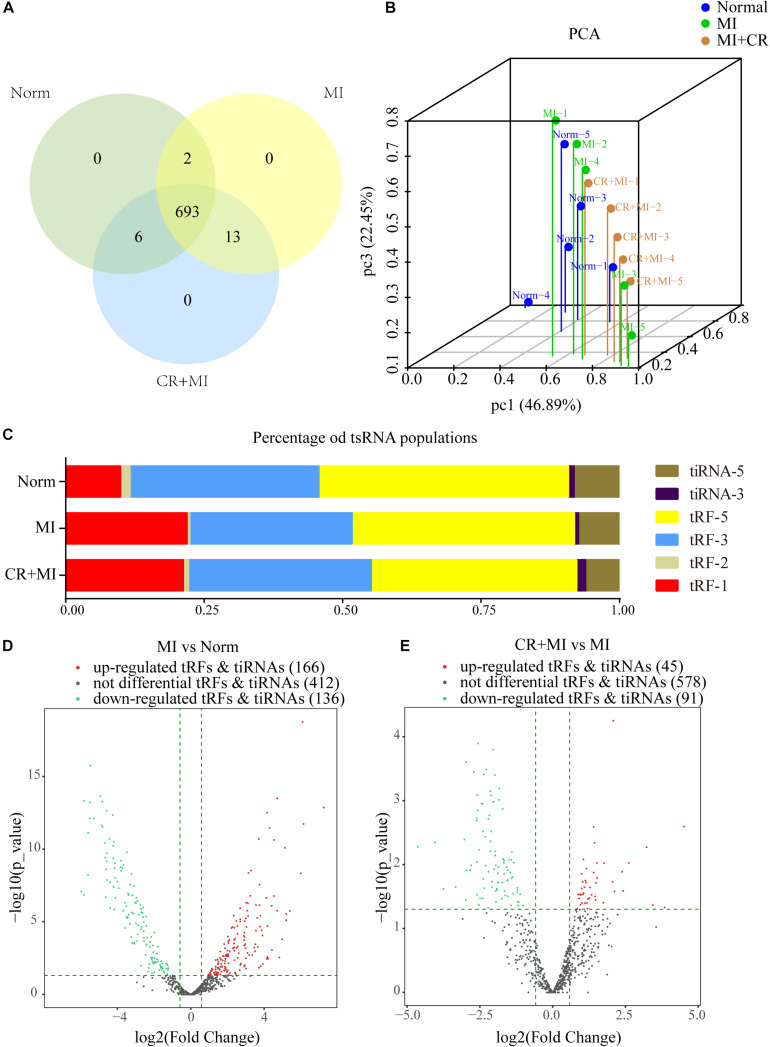
Altered expression profiles of tsRNAs following CR pretreatment. (A) Venn diagram indicating the total number of exact-matched tsRNAs in the myocardial tissues of norm, MI, and CR + MI groups. (B) PCA plot illustrating the clustering of three repeats in each group and evaluation of the corresponding variability and repeatability (FC > 1.5 and P < 0.05). The blue dots represent the norm group, the green dots represent the MI group, and the orange dots represent the CR + MI group. (C) Histogram showing the expression levels of each subtype of tsRNA in norm, MI, and CR + MI groups. (D) Volcano plot showing 302 significantly altered tsRNAs between the MI and norm groups (FC > 1.5 and P < 0.05). (E) Volcano plot showing 136 significantly changed tsRNAs between MI and CR + MI groups (FC > 1.5 and P < 0.05). Red indicates upregulated tsRNAs, and green denotes downregulated tsRNAs. The data are presented as the mean ± SEM (n = 5). *P < 0.05, **P < 0.01 compared with the MI group.